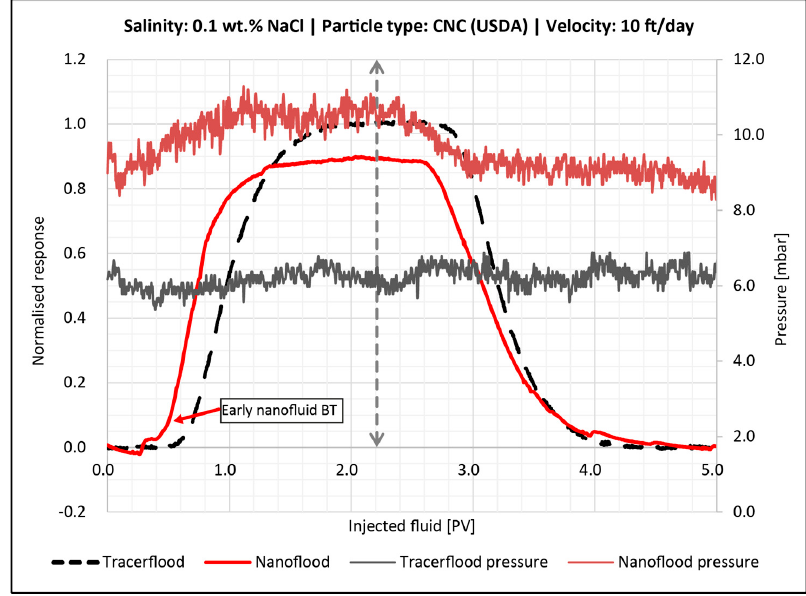
Figure 16. Breakthrough curve for the core flood with 0.5 wt. % CNC (USDA) in 0.1 wt. % NaCl (red line). 2.2 PV were injected followed by 0.1 wt. % brine. The dashed vertical line illustrates when post flush was started. The tracer BT-curve is the black dotted line. The corresponding pressure curves are also shown.